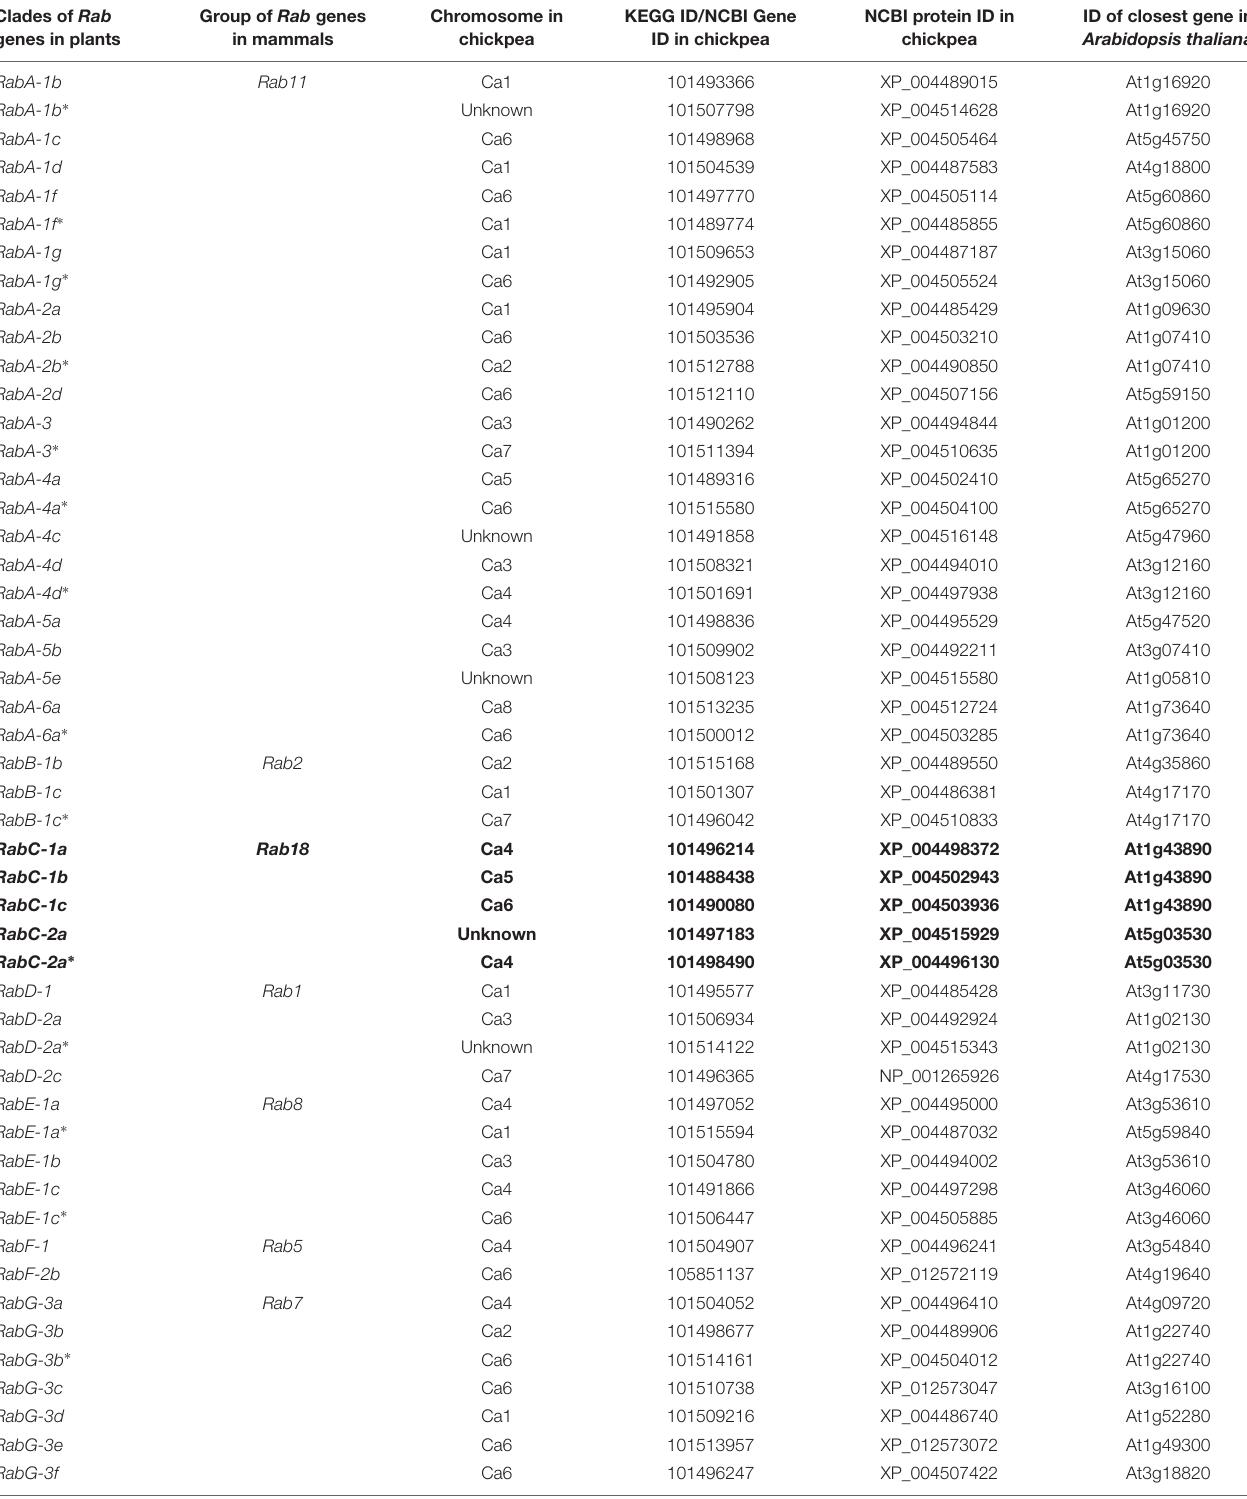
TABLE 2 | The eight identified sub-families ( RabA – RabH ) of the chickpea CaRab , with 54 isoforms and their corresponding accession ID listed for genes and proteins as well as reference to closest genes in Arabidopsis . Clades of Rab genes in